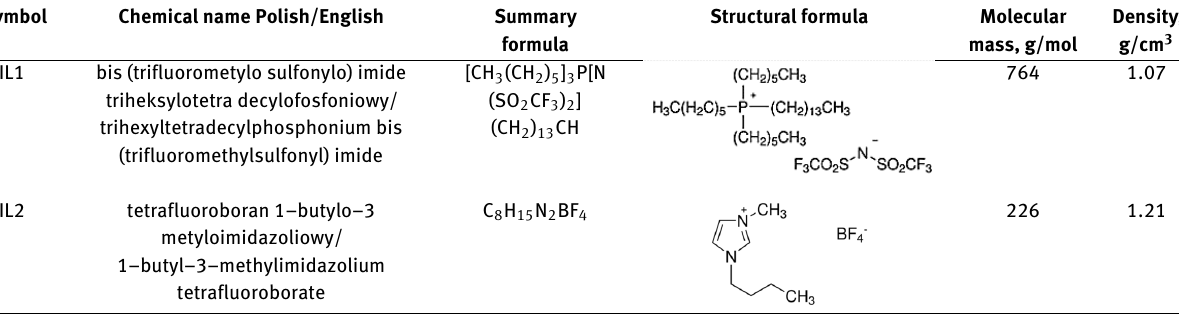
Table 1: Structures and selected properties of the analysed ionic liquids Symbol Chemical name Polish/English